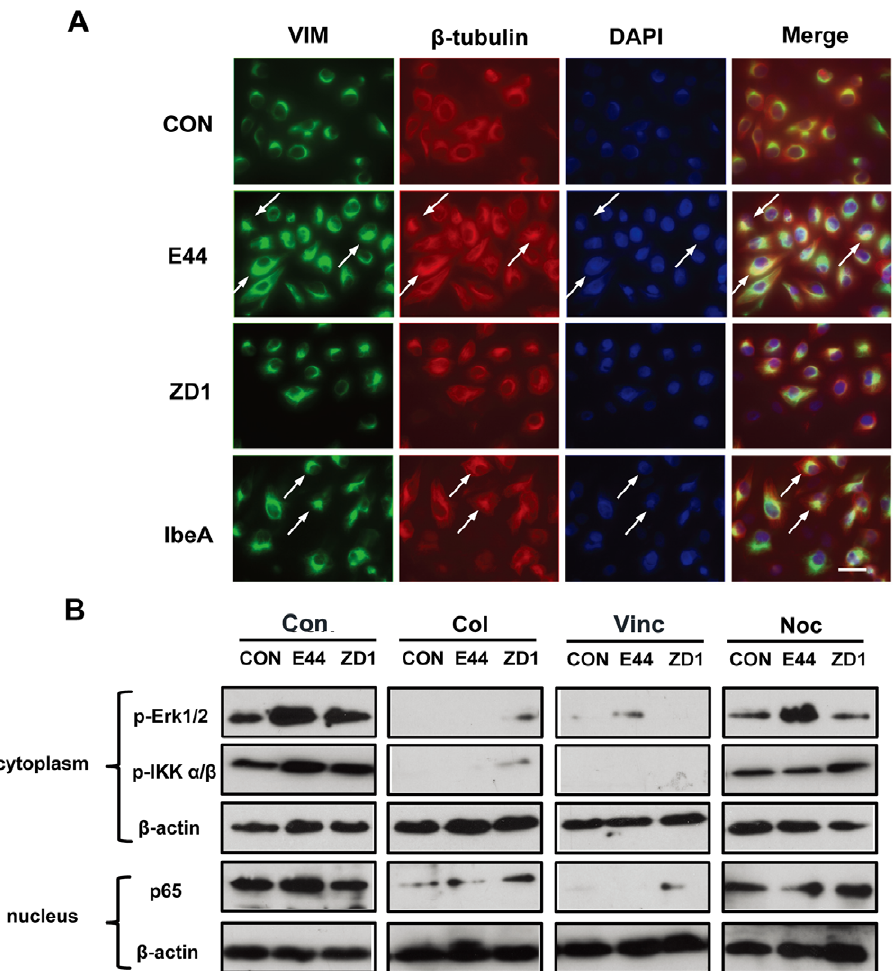
Figure 6. b -tublulin is required for IbeA + E.coli K1-induced NF- k B activation. ( A ) IbeA 2 and IbeA + E. coli K1-induced b -tubulin/vimentin clustering and colocalization. Immunofluorescence microscopy was used to examine the clustering and reorganization of vimentin and b -tubulin after 2 h of incubation with the IbeA protein (0.1 m g/ml), E44 or ZD1 (25 MOI). HBMECs were triple-stained with the V9 antibody against vimentin conjugated to FITC (green), the rabbit antibody against b -tubulin conjugated to rhodamine (red), and DAPI (blue). The merged images are shown in the right-hand panels (Merge). Arrows indicated cells with colocalization between vimentin and b -tubulin around the perinuclear region. Scale bar, 50 m m. ( B ) Blockage of IbeA + E. coli K1-induced cytoplasmic activation and nuclear translocation of NF- k B (p65) in HBMECs by the microtubule inhibitors. HBMECs were incubated with or without colchicines (Col, 2 m M), vincristine (Vin, 1 m M), nocodazole (Noc, 25 m g/ml) for 60 min before stimulation with E44 or ZD1 (10 7 /ml). Phosphorylation of ERK1/2 (p-Erk1/2) and IKK a / b (p-IKK a / b ) was examined in cytoplasmic fractions after 30 min of E. coli K1 treatment. NF- k B (p65) translocation to nucleus in nuclear fractions was examined after 2 h of E. coli K1 incubation. b -actin in both fractions was detected as internal loading controls. CON, control without bacterial